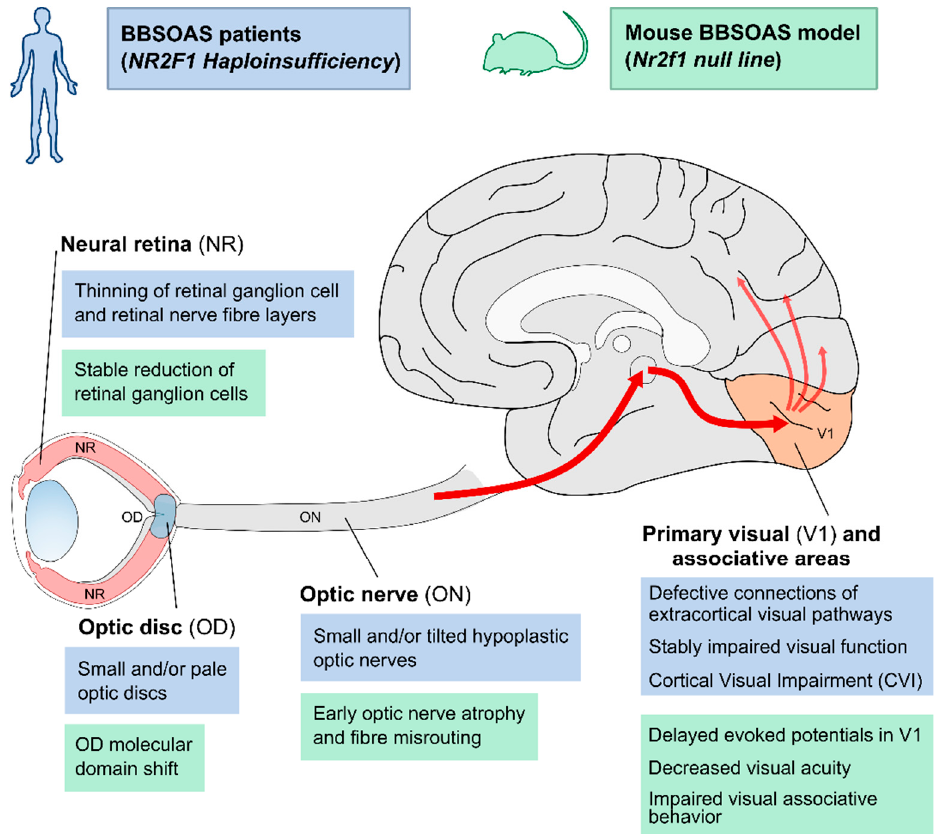
Figure 3. Overview of structural and functional defects along the visual pathway in BBSOAS patients and corresponding Nr2f1 mutant mouse models. CVI and other visual impairments reported in BBSOAS patients (blue boxes) might build upon structural impairment affecting several structures in the visual system, such as the neural retina (NR), the optic disc (OD), the optic nerve (ON), the primary visual area of the neocortex (V1) and its connections to secondary associative areas. The use of Nr2f1 mutant mouse models (green boxes) have helped in elucidating the molecular, cellular and functional mechanisms that could potentially cause the defects observed in patients.